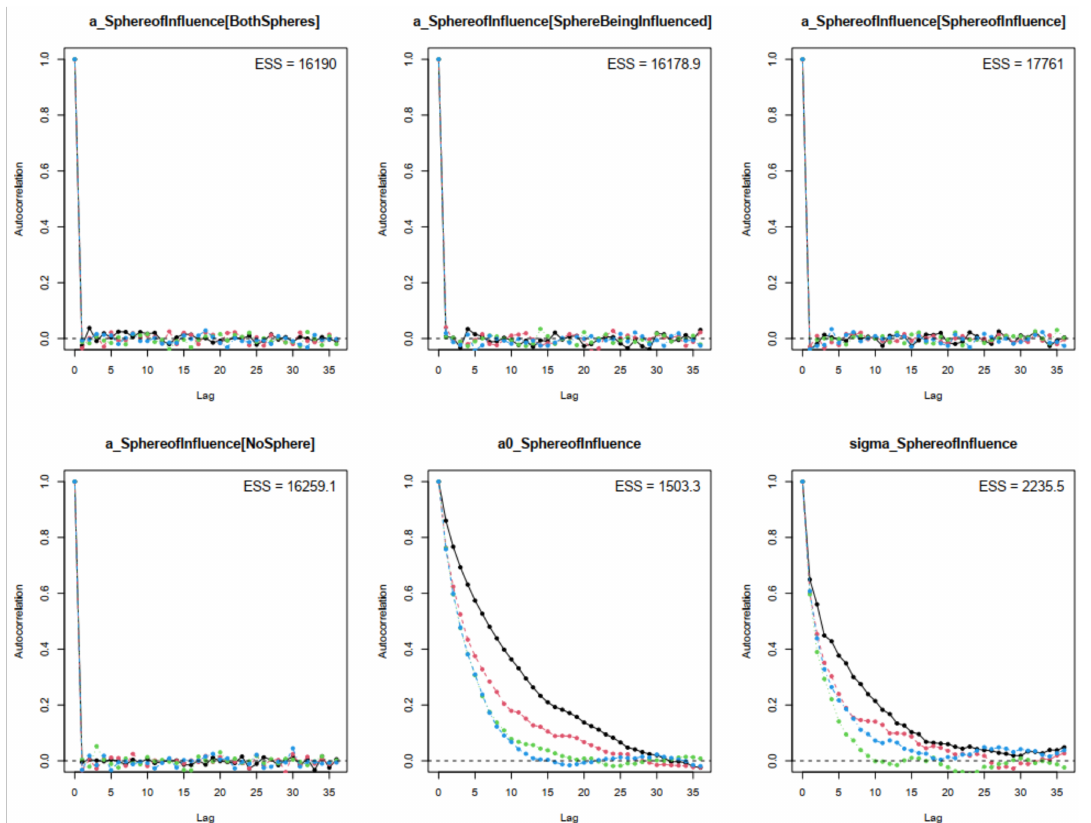
Figure A3. Model 1 (cid:48) s autocorrelation